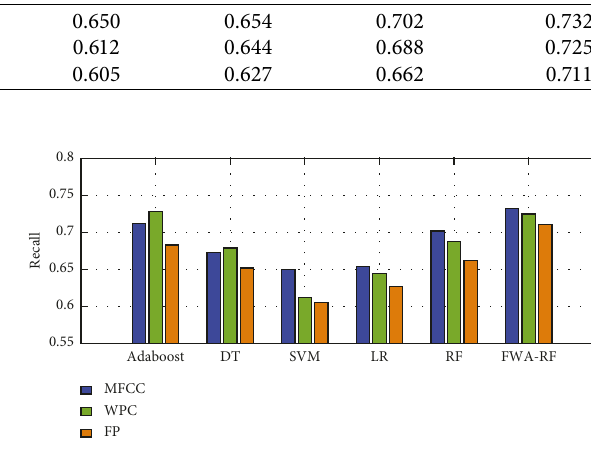
Table 2: The recall rate obtained by each classifier combined with different feature extraction methods. Classifier feature extraction